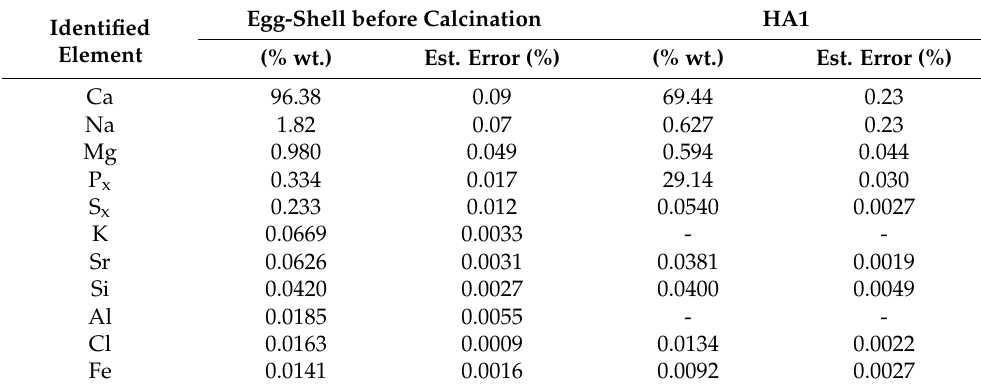
Table 3. Main elemental constituents of HA1 powder and egg-shells before annealing by XRF. Identified